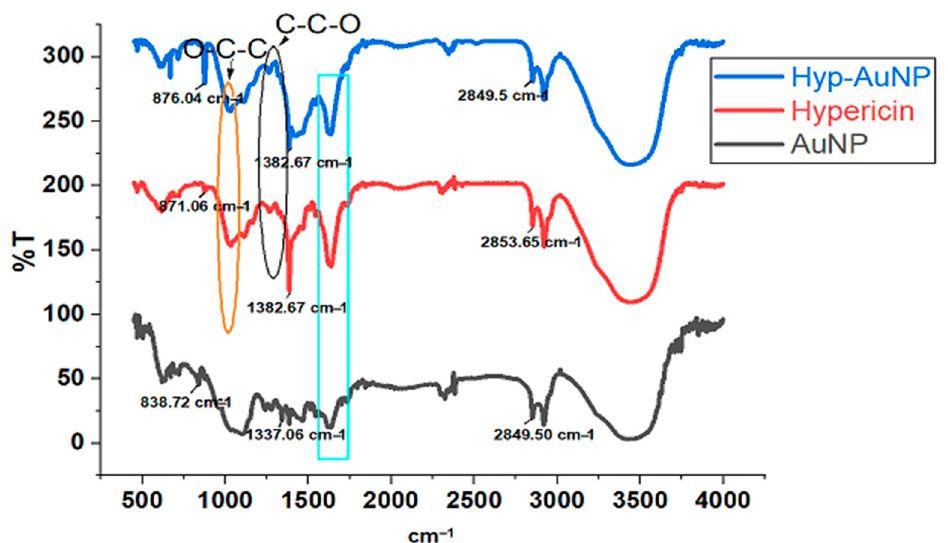
Figure 2. FTIR results of Hyp-AuNP compound, AuNP, and hypericin.